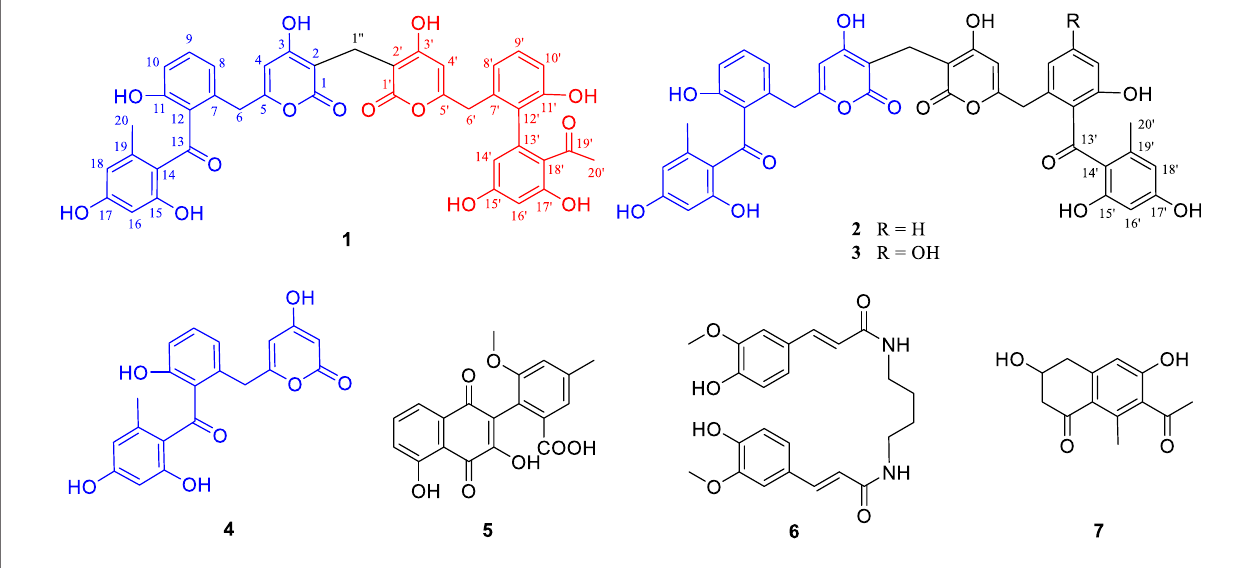
Frontiers in Chemistry |